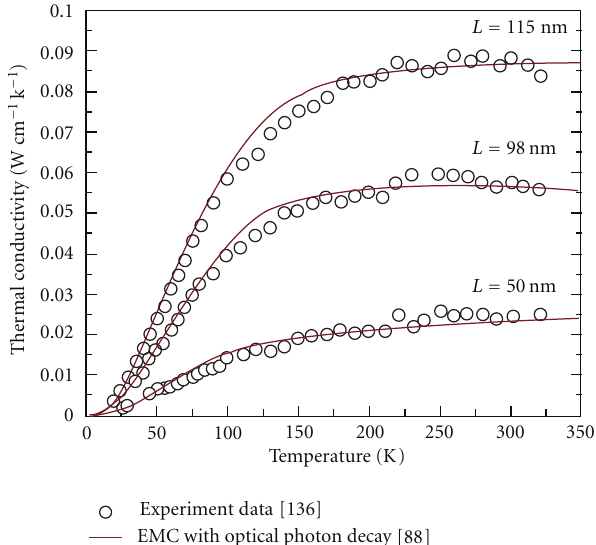
Figure 16: Thermal conductivity of rough Si nanowires. Open cir- cles are experimental results from [116], and solid lines are theo- retical results obtained from the elastic continuum model including acoustic phonon confinement and surface roughness